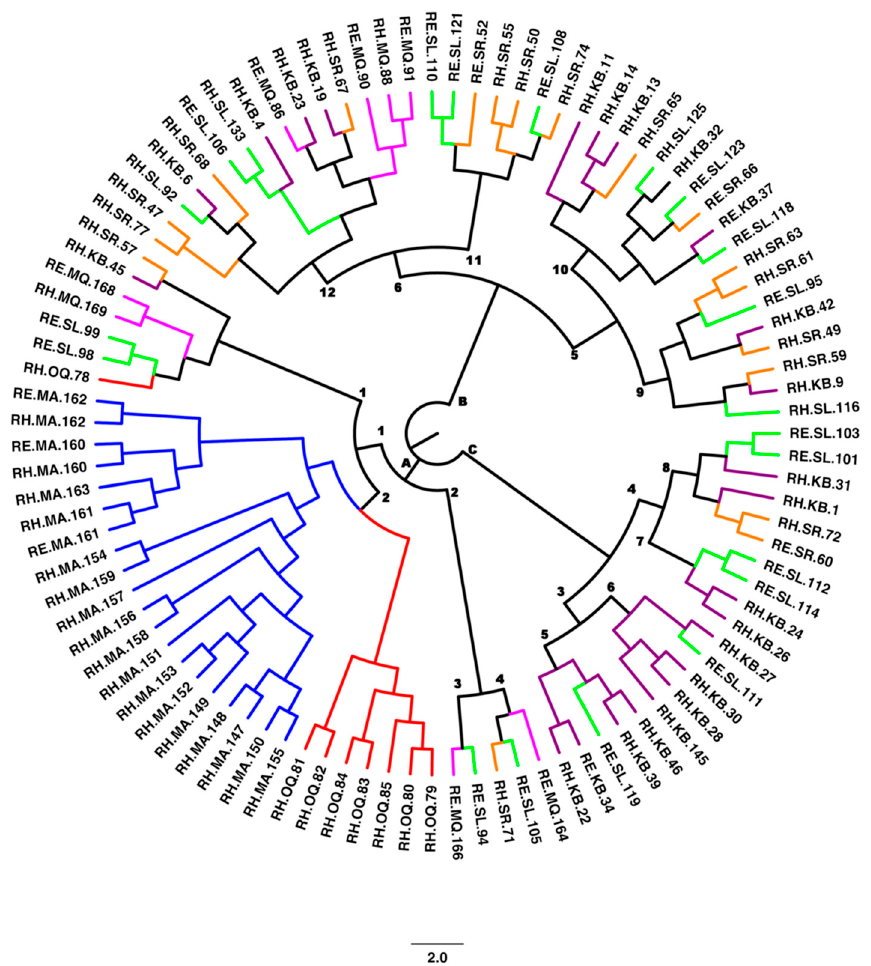
Figure 3. Cladogram showing population structure of 98 Rhanterium accessions sampled across six locations in Kuwait.